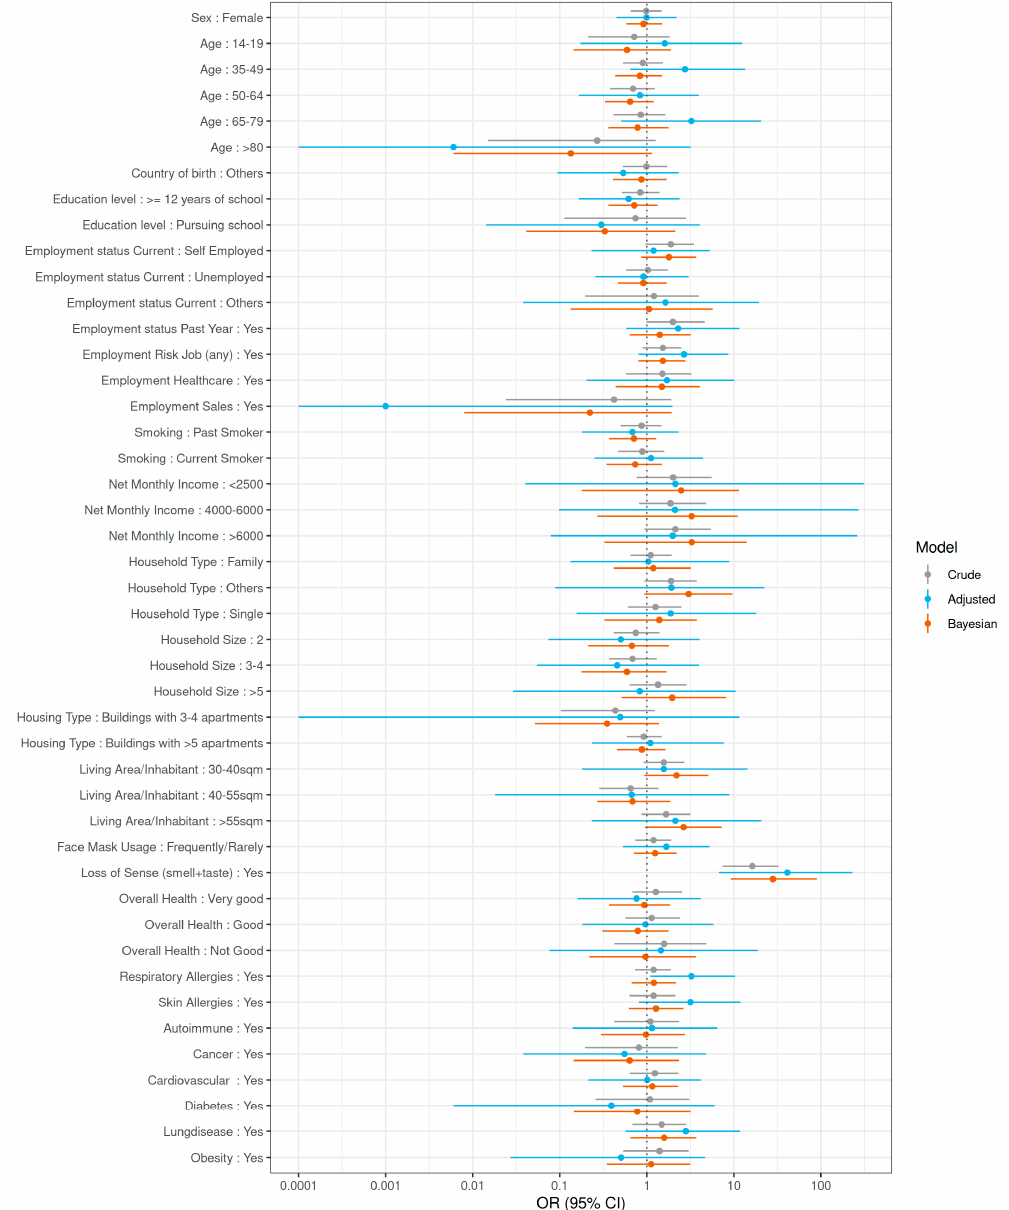
Figure 4. Risk factor analysis for SARS¬CoV-2 seropositivity. Risk factor analysis for SARS¬CoV-2 seropositivity in the KoCo19 study population comparing crude, adjusted for clustering, and Bayesian (after imputation and adjusted for clustering) estimates. All odds ratios (ORs) and 95% CIs were adjusted for age (continuous scale) and sex. OR: odds ratio; 95% CI: 95% confidence interval (frequentist GLMM)/95% credible interval (Bayesian analyses).